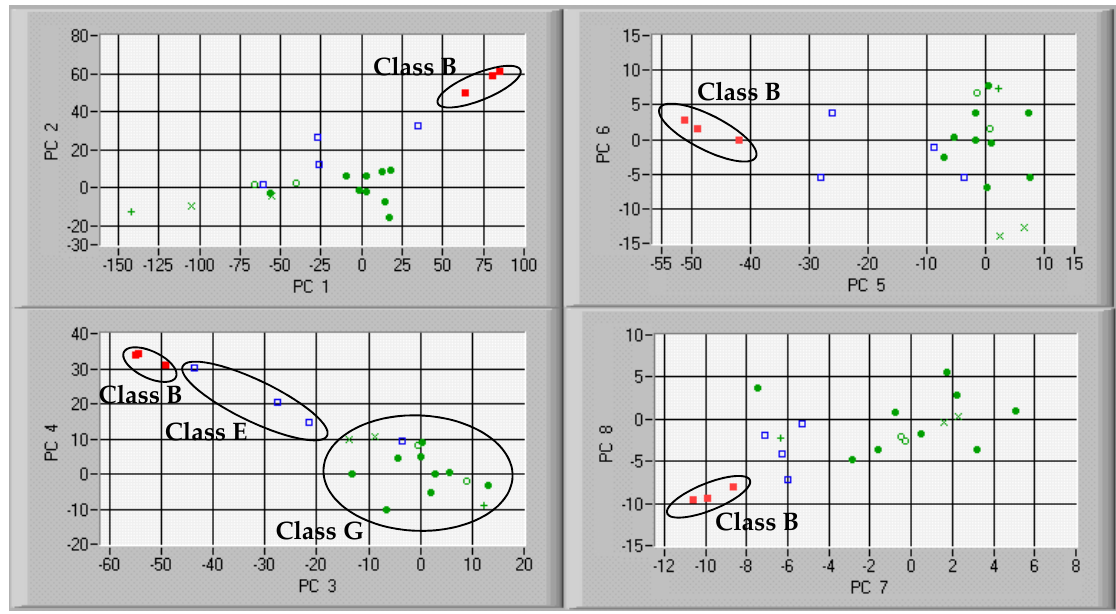
Figure 11. Representation of devices by PC1–PC8 for acquisition time equal to 10 min.